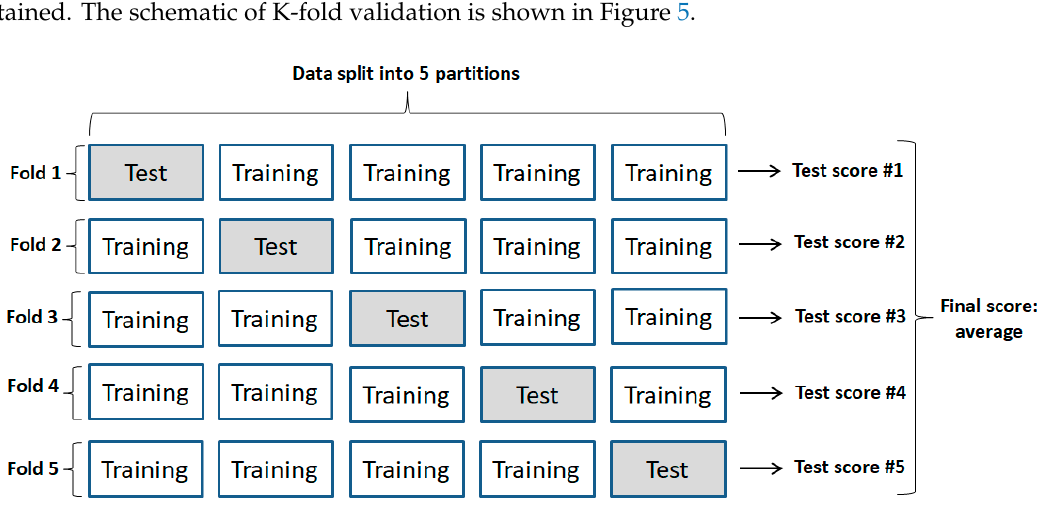
Figure 5. Schematic of K-fold cross-validation.